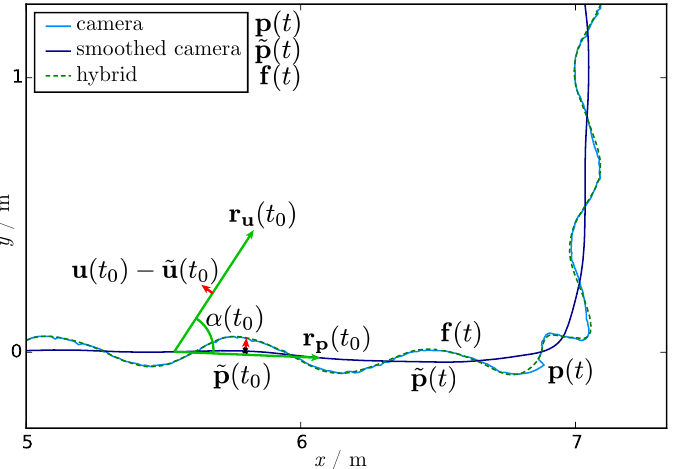
Figure 3. Enlarged cropped region of Figure 2 showing the rotation angle α between the main movement directions of the smoothed camera r p , and the IMU trajectory r u visualized as a green arrow in each case. The red arrow shows the difference between the head trajectory of the IMU system u and the smoothed IMU trajectory ˜ u , whose rotated vector was added to the smoothed camera trajectory ˜ p (dark blue path) to get the resulting fused trajectory f (green dashed path). The jerk in the camera trajectory in the bottom right came from a temporary loss of sight of the tracked black